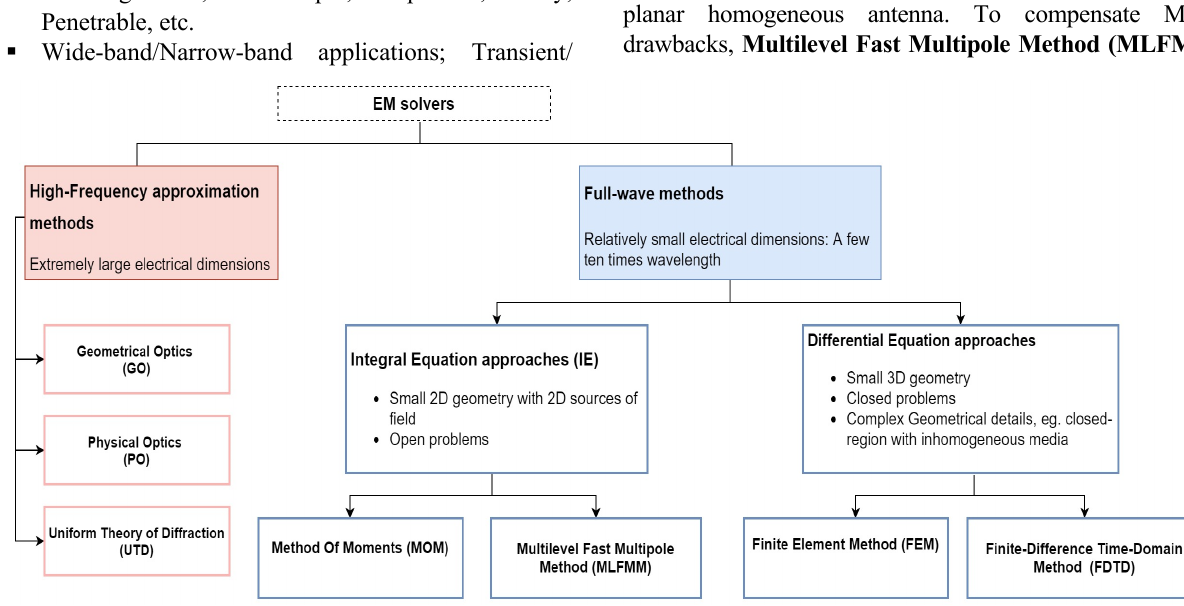
Figure 1. CEM solving methods